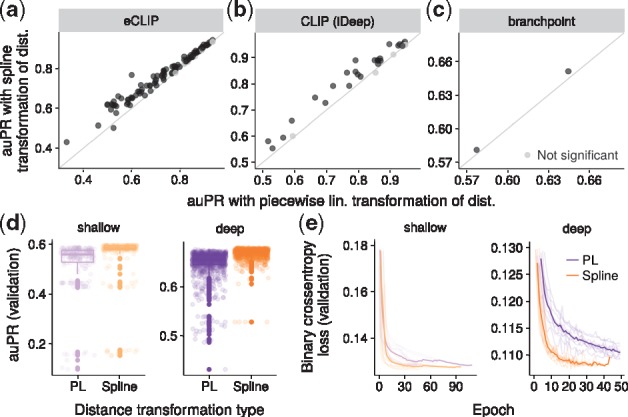
Spline transformation outperforms piecewise linear transformation in terms of generalization accuracy, hyper-parameter robustness and training efficiency. (a–c) Test accuracy (auPR) comparing spline transformation to piecewise linear transformation for all the tasks presented in the paper (Figs 2c and d and 3c). Black represents statistically significant difference (P < 0.0001, Wilcoxon test on 200 bootstrap samples, Bonferroni correction for multiple testing). (d and e) Training and hyper-parameter tuning metrics for the branchpoint task. PL, piecewise linear. (d) Validation accuracy (auPR) of all the hyper-parameter trials. (e) Training curves (validation loss per epoch) of 10 best hyper-parameter trials (transparent lines) and their average (solid line)